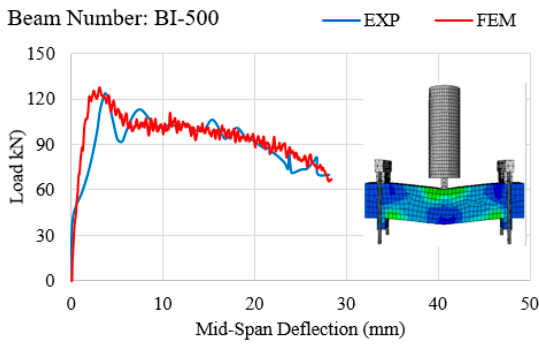
Figure 8. Load vs. mid-span deflection for BI-500.